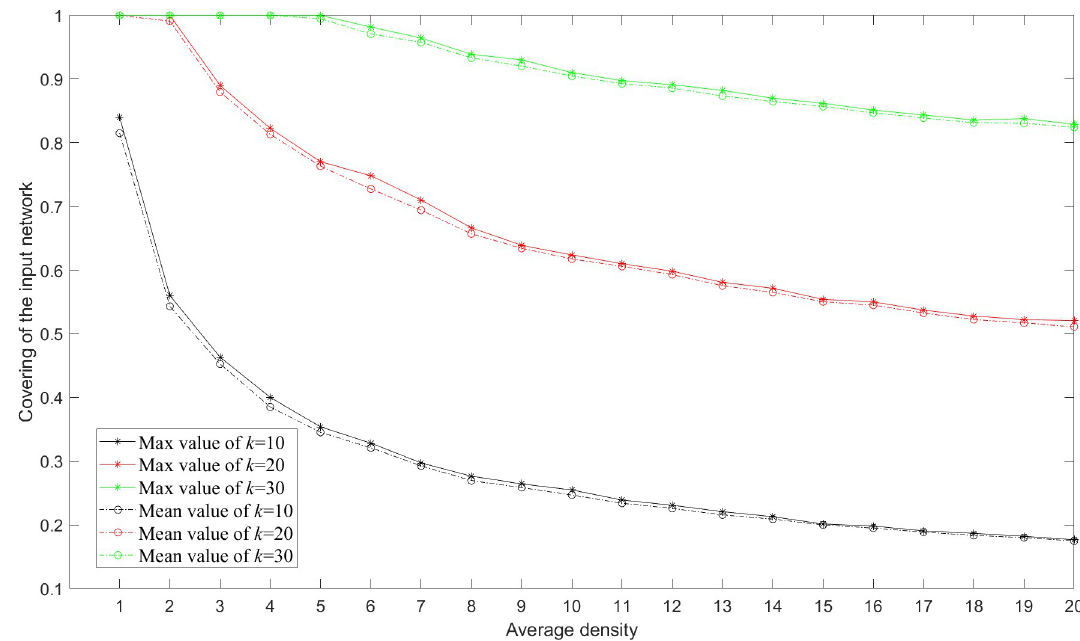
Fig 13. Covering of the input random 100-node network with different average densities given the number of subgraphs m = 10 and the subgraph size k = 10, 20 and 30 acquired by MA-M m C k SP.